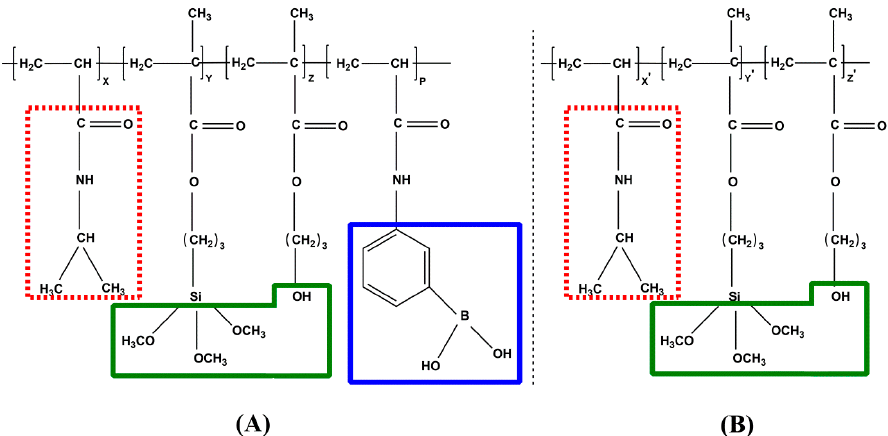
Figure 1. Molecular structure of PNAHT ( A ) and PNHT ( B ) copolymers.